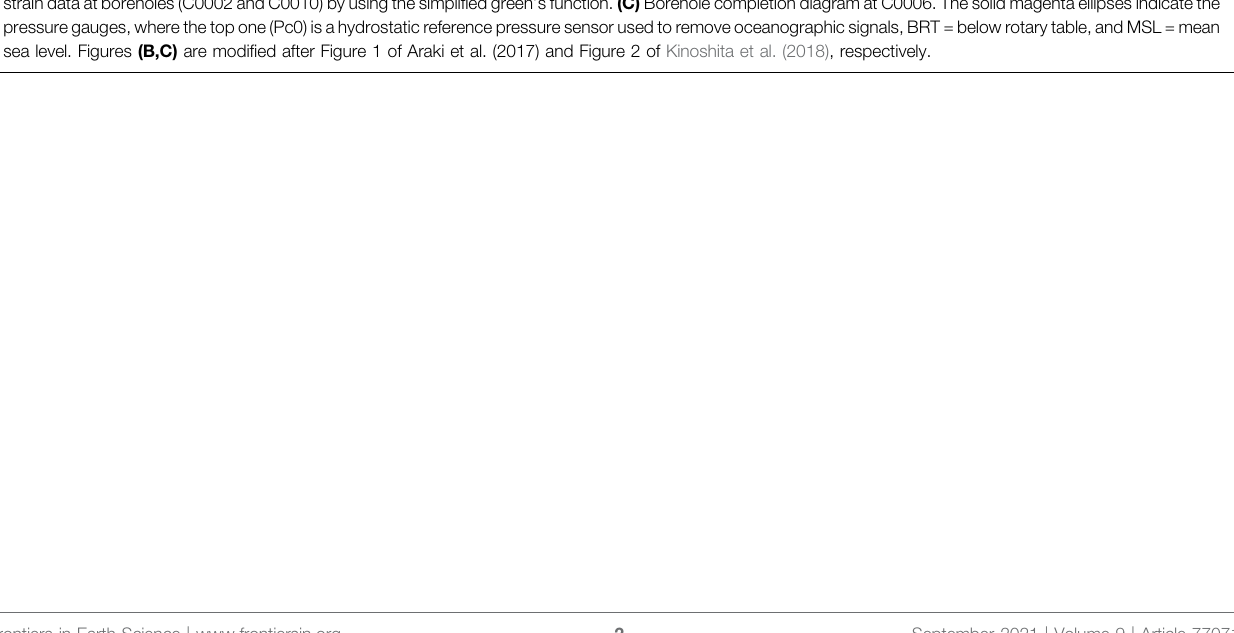
Frontiers in Earth Science |